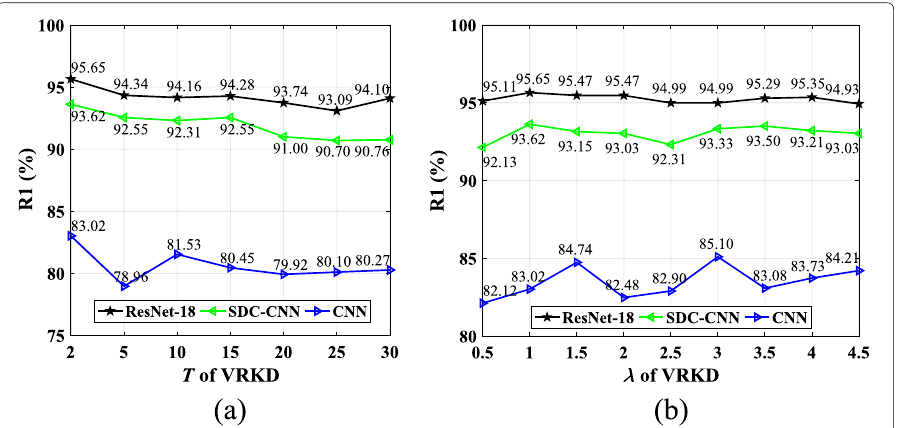
Fig. 6 a Different student networks’ R1 via varying distillation temperatures. Here, the KLD loss’s weight (i.e., λ of Equation (1)) is set to 1. b Different student networks’ R1 via varying of KLD’s weights (i.e., λ of Equation